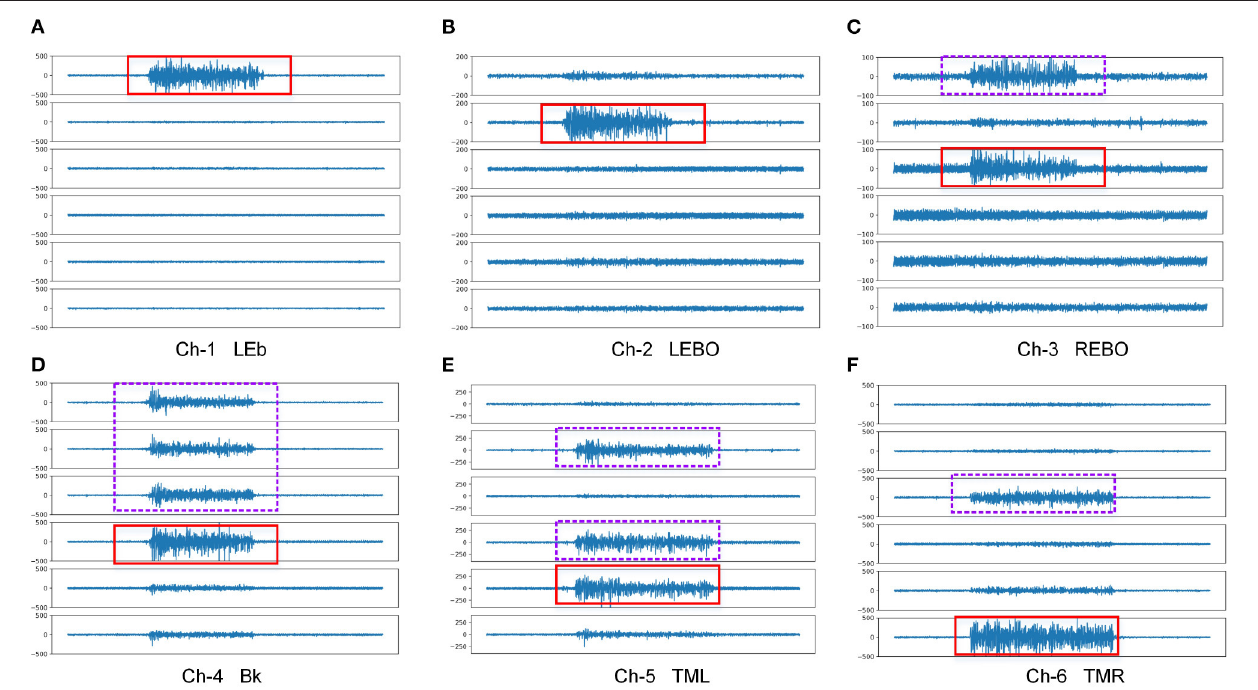
FIGURE 5 | Waveform comparison between different actions and channels. In the figure, the waveform in the solid red frame is the main channel signal corresponding to the action, and the waveform in the purple dashed frame is redundant signal collected by other channels. (A) Ch-1 LEb, (B) Ch-2 LEBO, (C) Ch-3 REBO, (D) Ch-4 Bk, (E) Ch-5 TML, (F) Ch-6